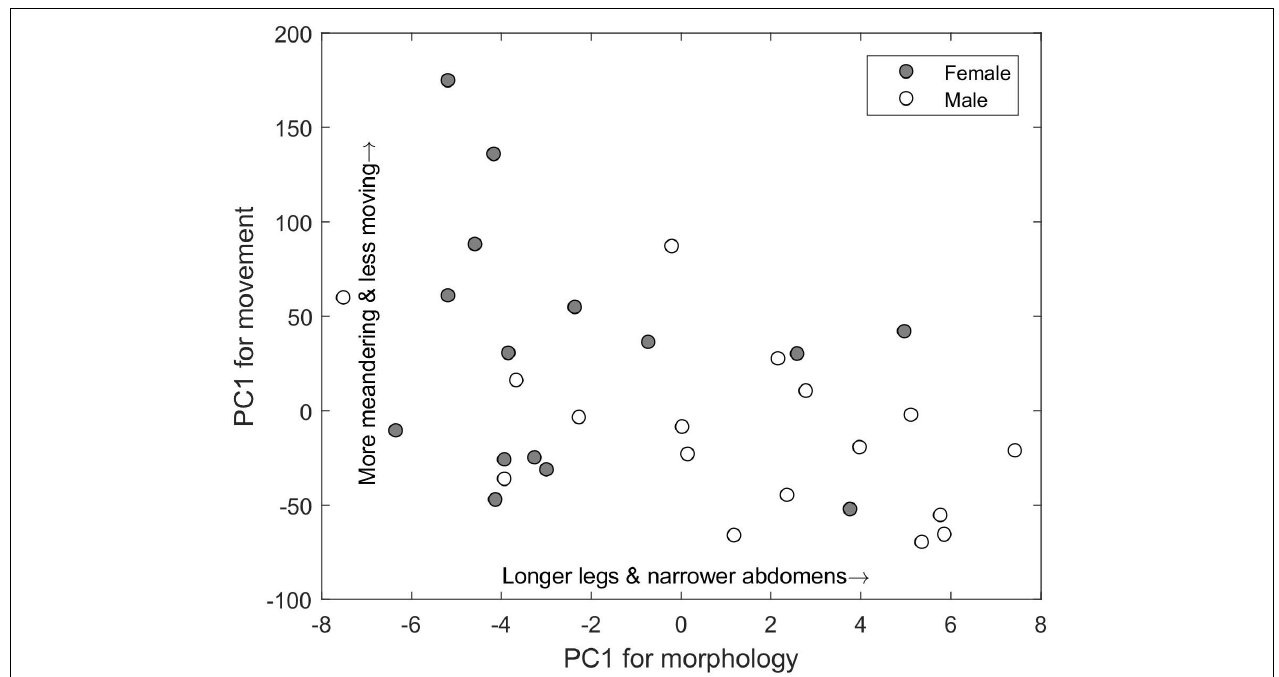
FIGURE 4 | Relationship between the first principle components axis for a group of movement variables ( y -axis) and a group of morphological and physiological variables ( x -axis) of the wolf spider Schizocosa mccooki . These two principle components are correlated, generating a movement-morphology axis of traits. Males tend to occur along this continuum toward having longer legs and narrower abdomens and moving with less meandering but more movement